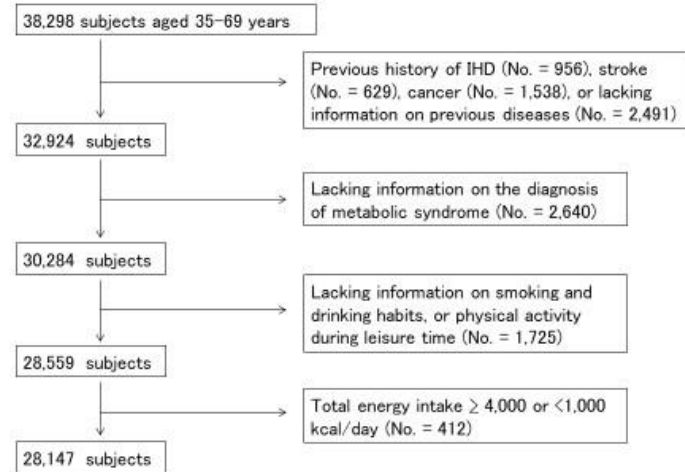
Figure 1. Selection-process flowchart for study subjects. Among 38,298 participants in baseline survey of the Japan Multi-Institutional Collaborative Cohort (J-MICC) study, 28,147 subjects (14,042 men and 14,105 women) were analyzed.